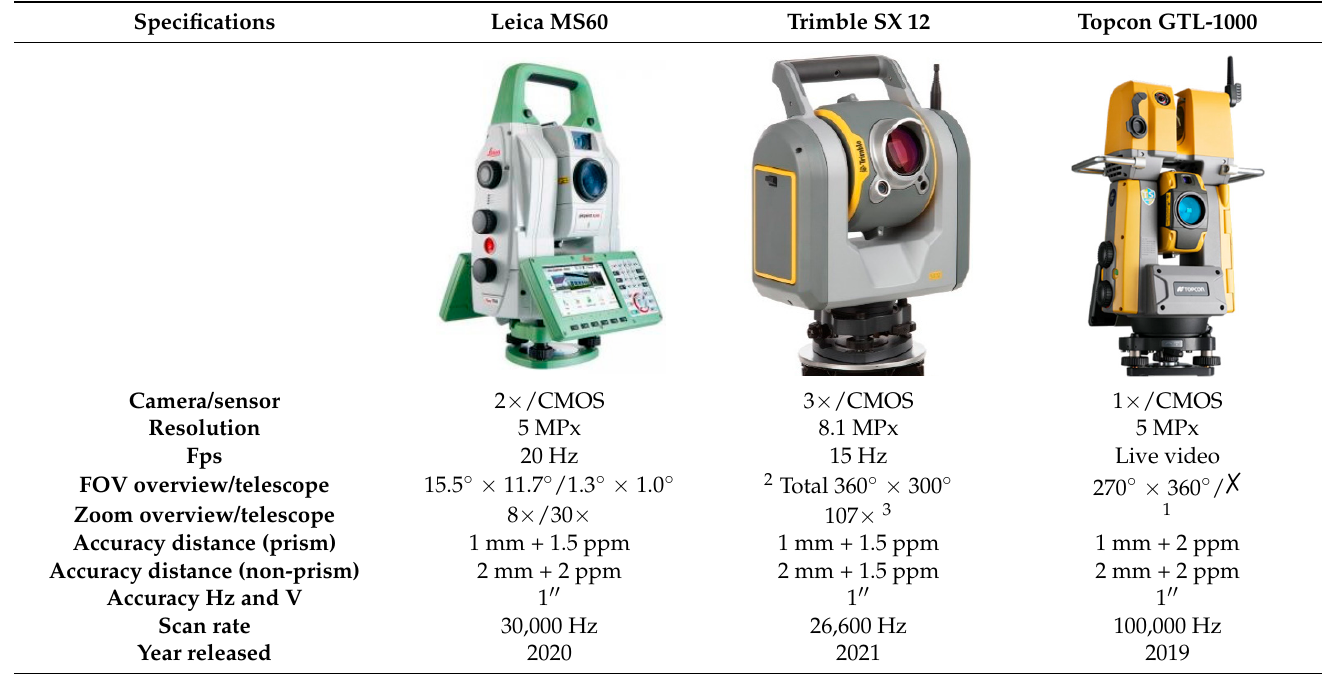
Table 2. Main specifications of currently available IASTS [51,53,54].